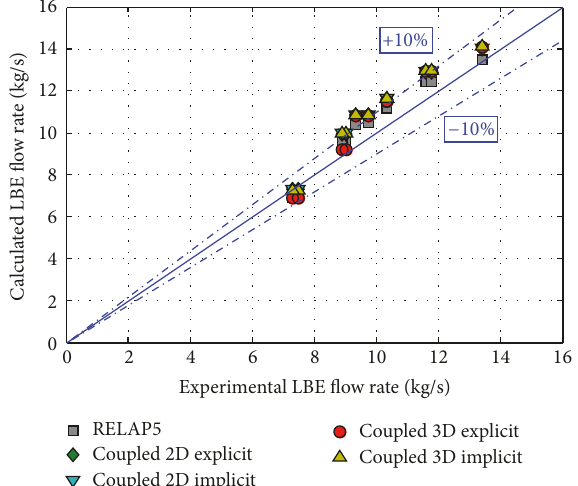
Figure 8: Average values of the LBE mass flow rate for Test F400 in NACIE